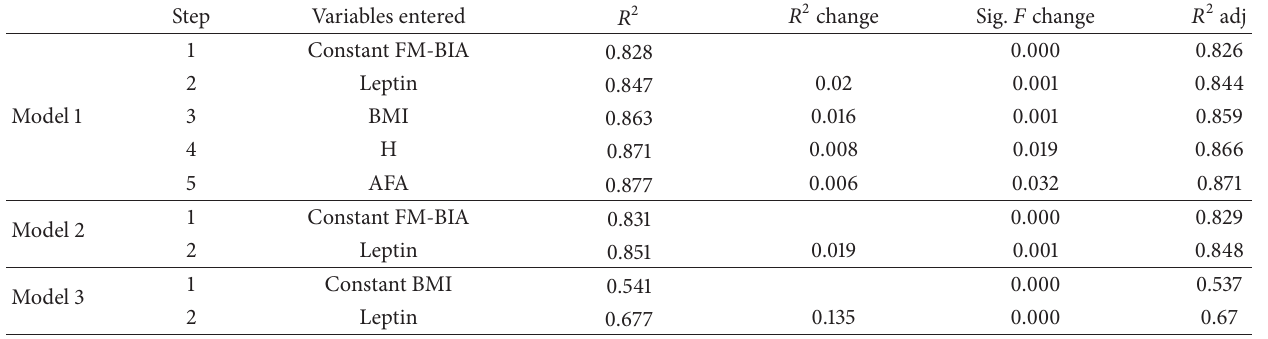
Table 5: Forward stepwise multivariate regression analysis (FM from DXA as dependent